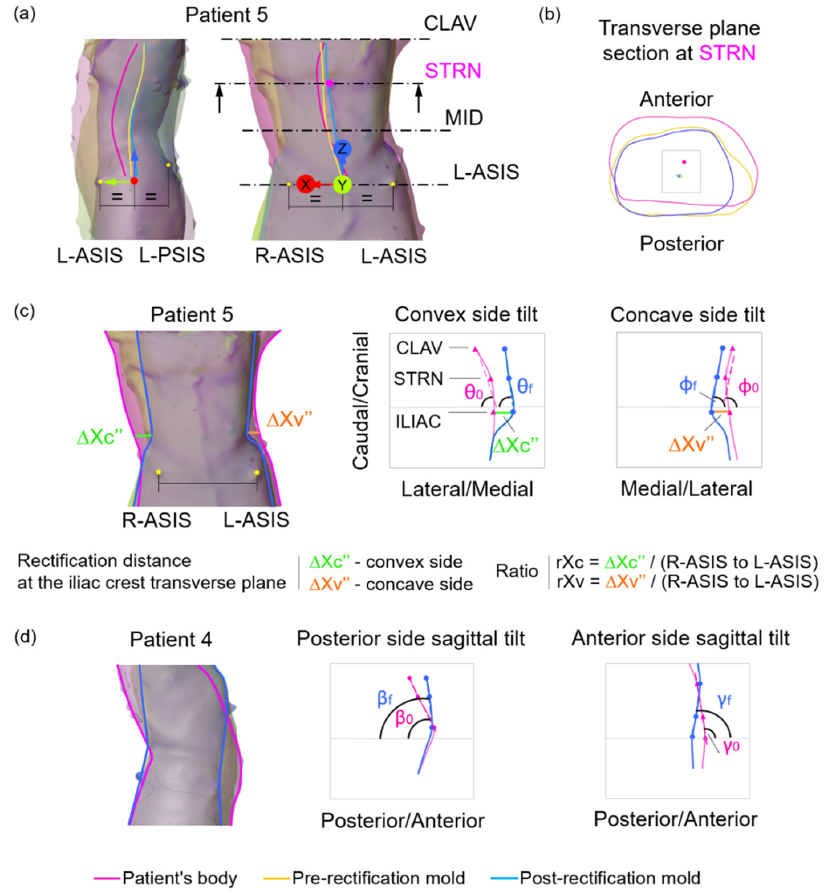
Figure 4. Surface centroids and 3D surface deviation analyses. ( a ) The centroid trajectories of the body, pre-, and post-rectification mould scans from patient five. Dashed lines represent the transverse sections at marker level (CLAV, STRN, and L-ASIS). MID is a section at equal distance between STRN and L-ASIS. ( b ) External contours and centroids for the STRN section of patient five. ( c ) External lateral contours of patient’s five body and post-rectification mould scan on the convex and concave side with their corresponding tilt angles and rectification distances at the iliac crest transverse plane ( ∆ Xc” and ∆ Xv”). ( d ) External anterior and posterior contours of patient’s four body and post-rectification mould scan with their corresponding tilt